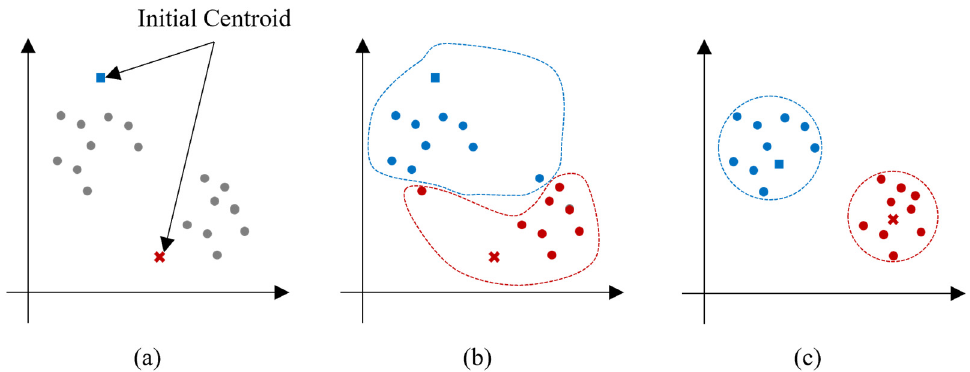
Figure 5. K-means clustering algorithm process: ( a ) initial step, ( b ) centroid update step, ( c ) completed